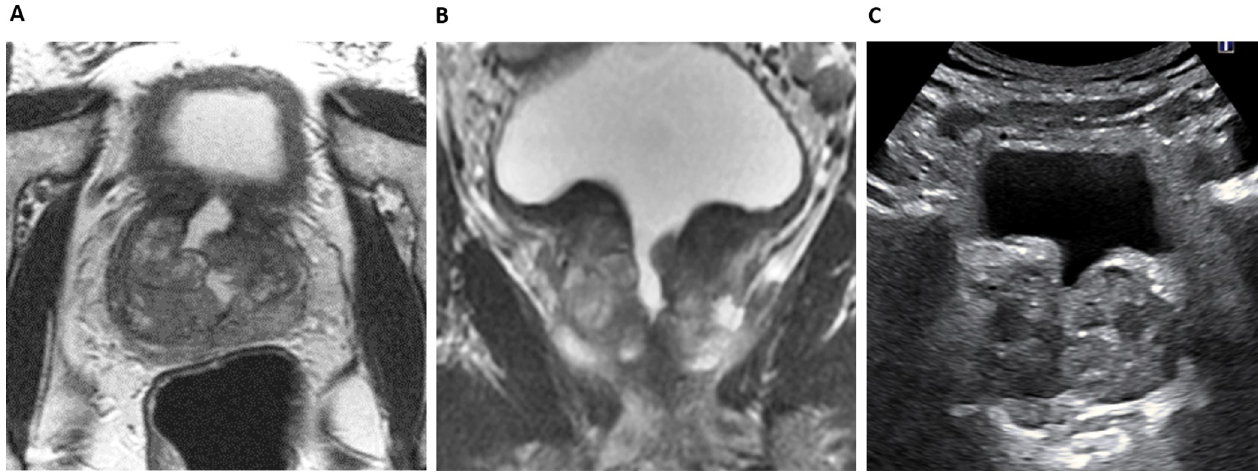
Fig 3. TURP defect affects measurements. Axial (A) and coronal (B) T2-weighted images show TURP defect at the base of the gland, with corresponding transverse transabdominal US image (C). MRI triplanar and segmentation volumes will differ, and sagittal US measurements will vary depending if the gland is measured in the midline position, or more laterally.